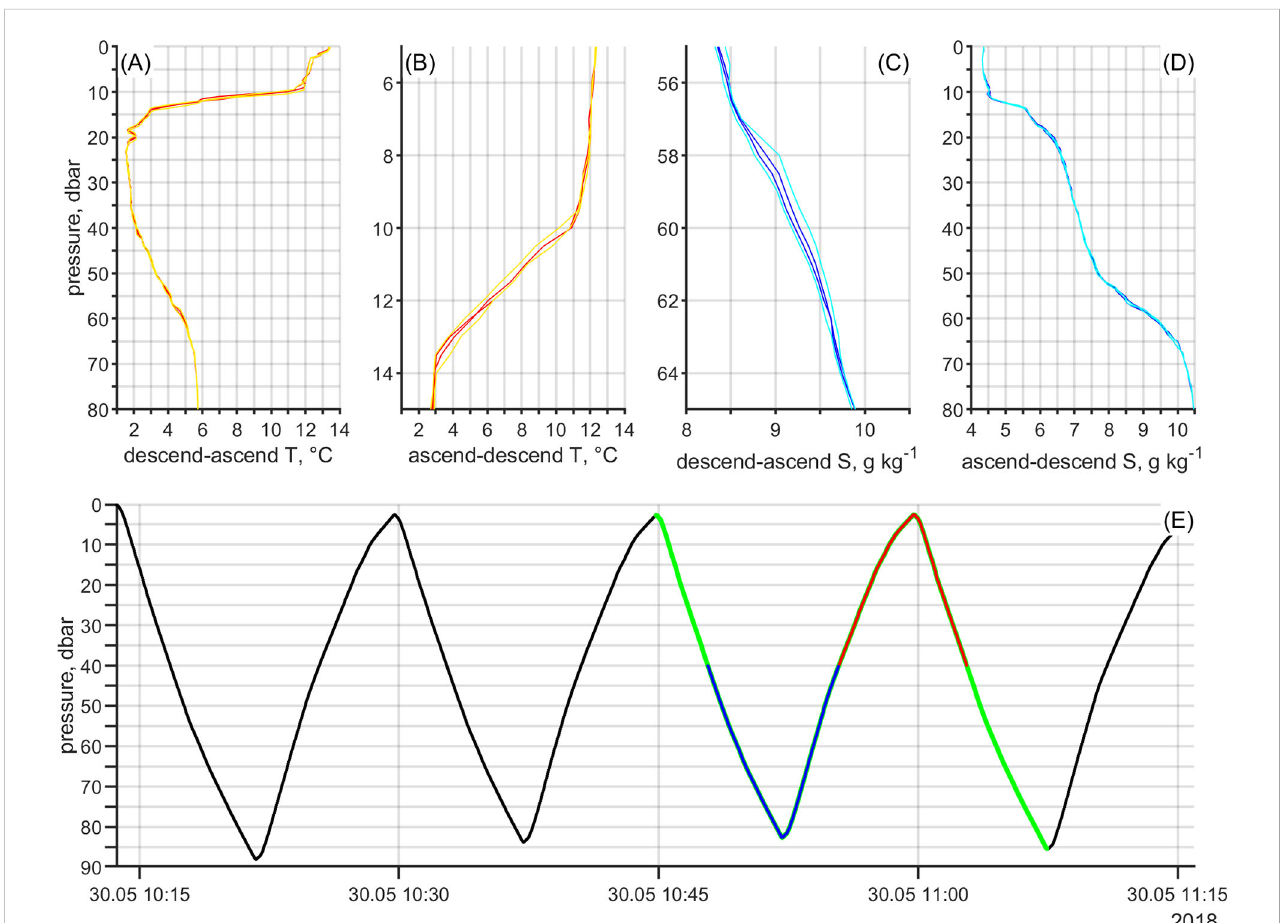
FIGURE 9 (A, B) Examples of raw (yellow) and corrected (response time, red) temperature pro fi les respectively over the water column and the thermocline depth range in case of descend-ascend (highlighted with blue in E ) and ascend-descend (highlighted with red in E ). (C, D) Examples of raw (cyan) and corrected (thermal lag, blue) salinity pro fi les respectively over the halocline depth range and the water column in case of descend-ascend and ascend- descend. (E) An example of a cycle shown as a time series of pressure. Green highlights the consecutive pro fi les. Overlaid blue shows the parts of pro fi les with a " ∨ " shape, and red a " ∧ "